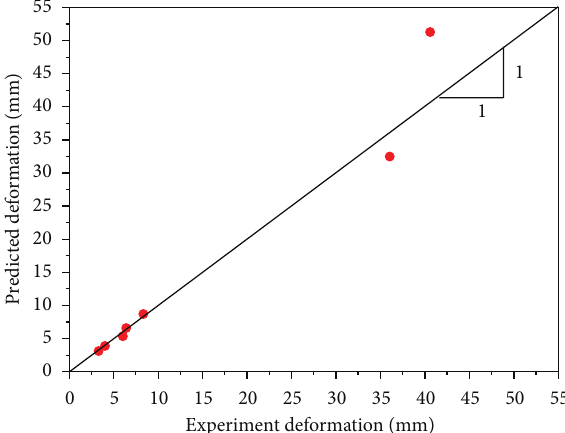
Figure 5: Comparison of experimental and predicted midspan